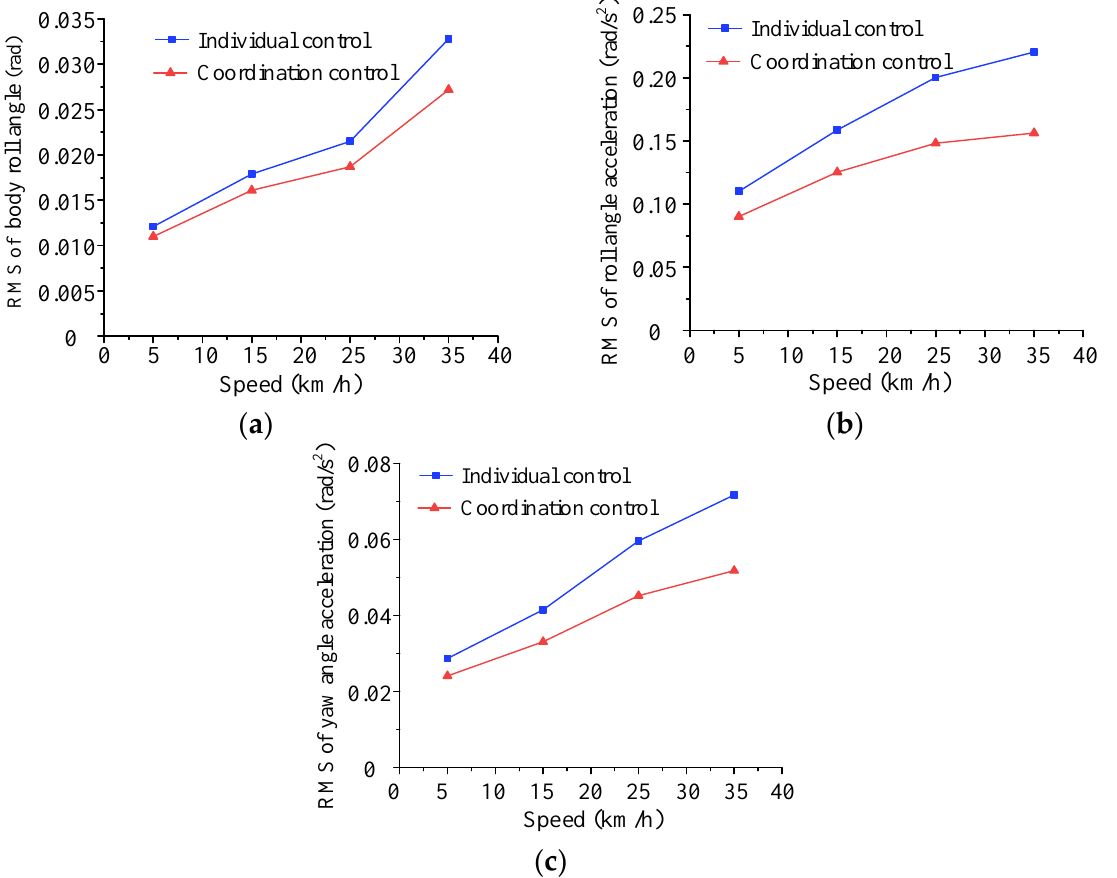
Figure 9. Comparison diagram of RMS values at different speeds: ( a ) body roll angle; ( b ) roll angle acceleration; ( c ) yaw angular acceleration.